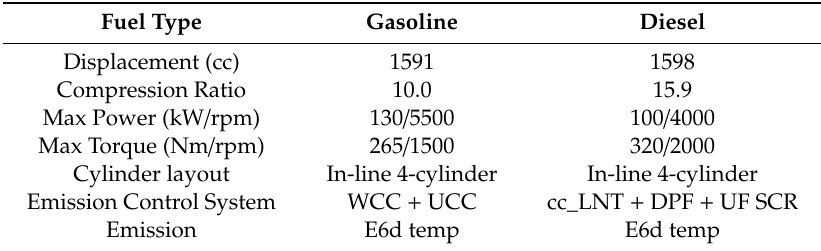
Table 3. Engine specifications in the test car.